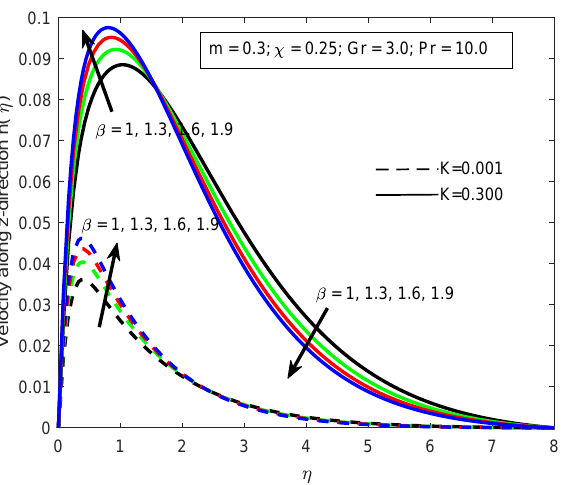
Figure 12: Variation of shear stress profile with small magnitudes of Casson fluid parameter